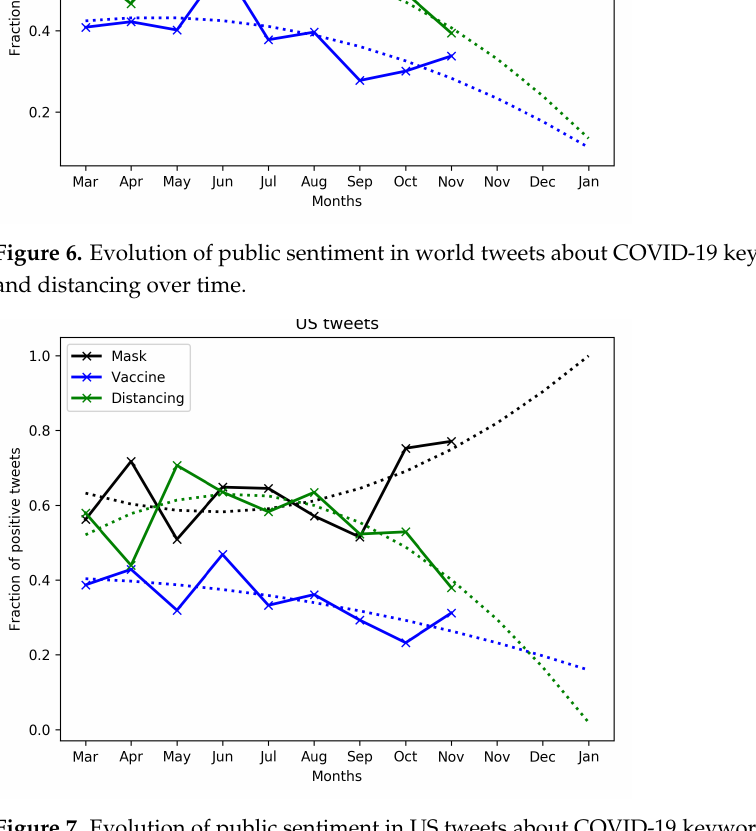
Figure 7. Evolution of public sentiment in US tweets about COVID-19 keywords, vaccine, mask, and distancing over